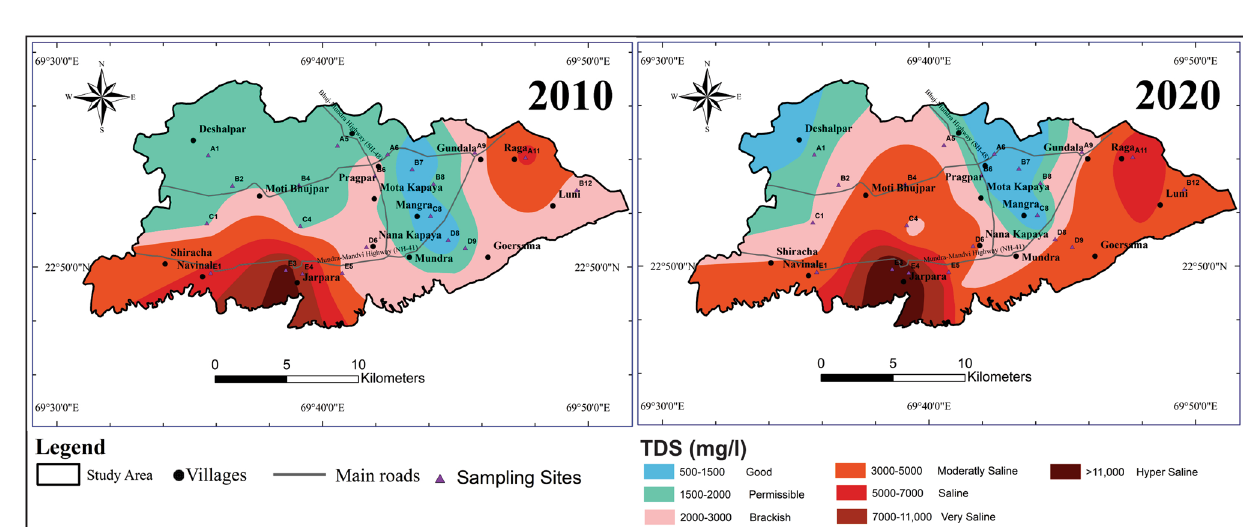
Fig. 2 Geospatial distribution of total dissolved solids (TDS) (Mg/L) of 2010 (Bhimani 2013 and 2020) Table 3 Statistical analysis of physicochemical parameters of the groundwater samples Sr